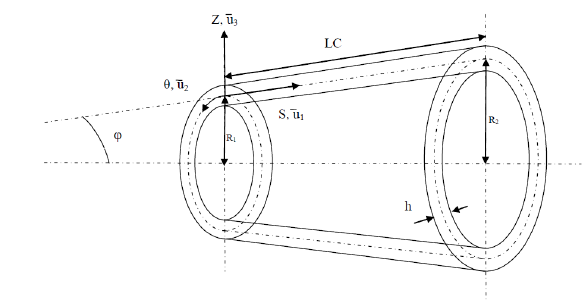
Figure 1: Geometry of laminated composite cone lamina with geo- metrical